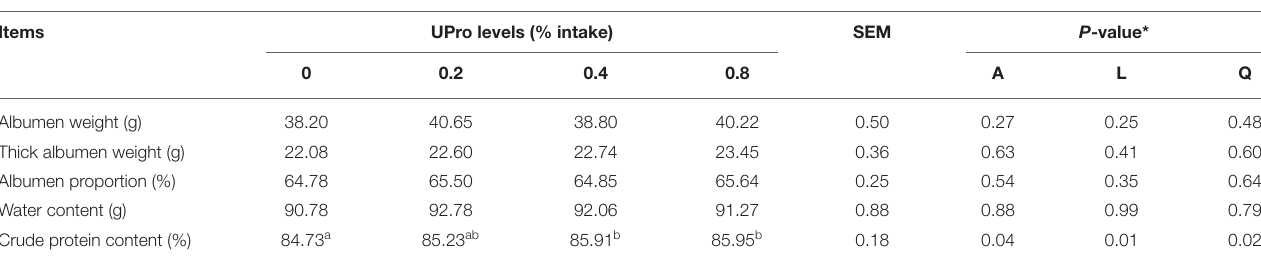
TABLE 5 | Effects of dietary UPro on albumen quality of laying